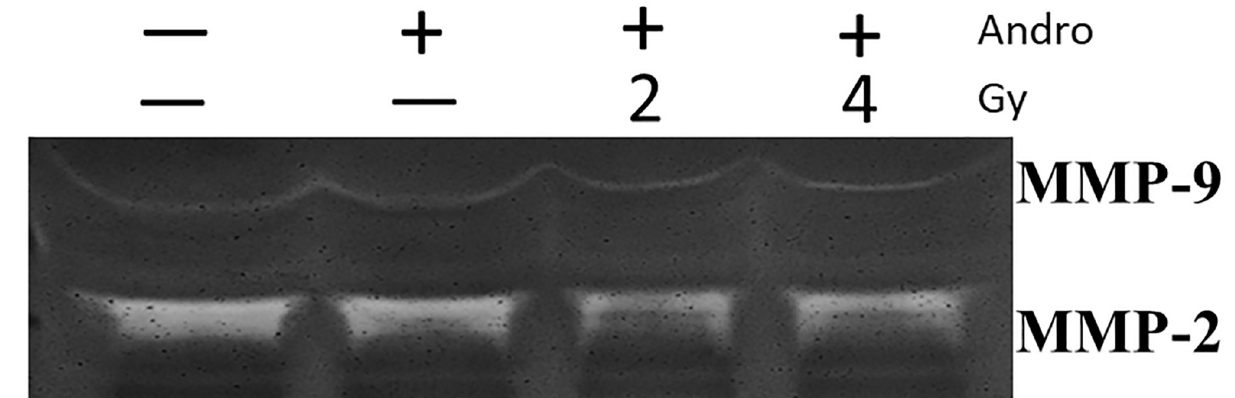
Fig 3. Andrographolide and radiation reduces MMP-2 expression. Gelatin zymography was performed using the conditioned media that were harvested after 48 hours in the presence or absence of 10 uM andrographolide, and then treated with/without radiation (2 or 4Gy) for 24 hours. The samples were applied without reduction to a 10% polyacrylamide gel containing gelatin, and proteolytic activity was demonstrated by digestion of the gelatin and clearing of the gel.